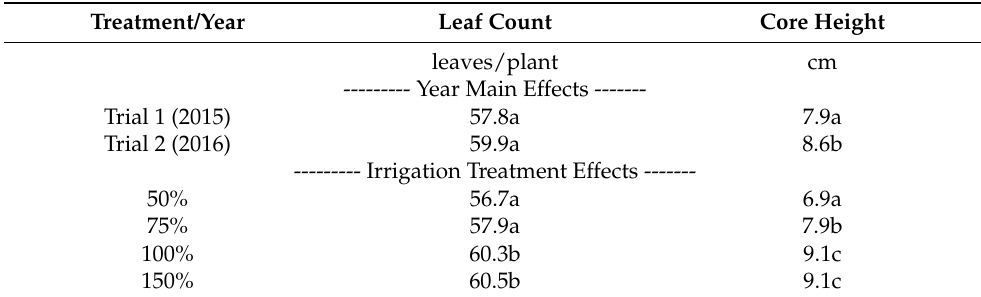
Figure 2. Average cored product yield per treatment from pooled 2015 and 2016 data. Treatments are 50–150% of crop water requirement. Irrigation treatments means with different letters are statistically different at the p < 0.05 confidence level. Error bars represent standard deviation of treatment means. Table 3. Average leaf count and core height of untrimmed romaine heads from trials 1 and 2 (combined data across irrigation treatments), and of irrigation treatments (combined data from both trials). Treatments are 50–150% of crop water requirement. Means with different letters are statistically different at the p < 0.05 confidence level.